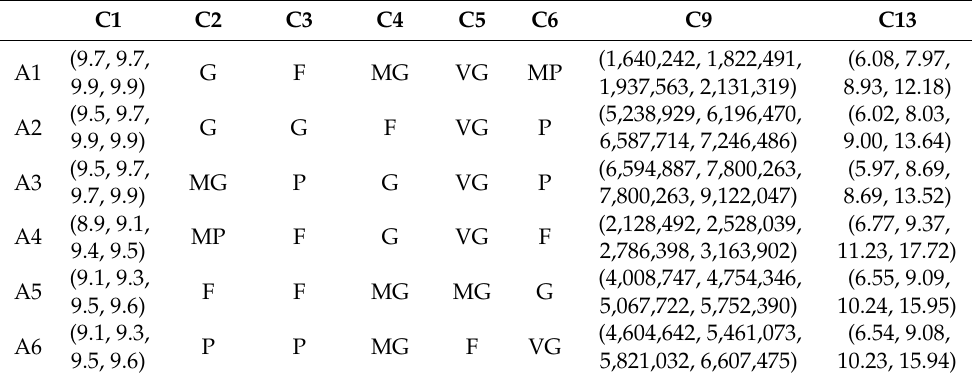
Table 4. Assessments of expert alternatives E 2